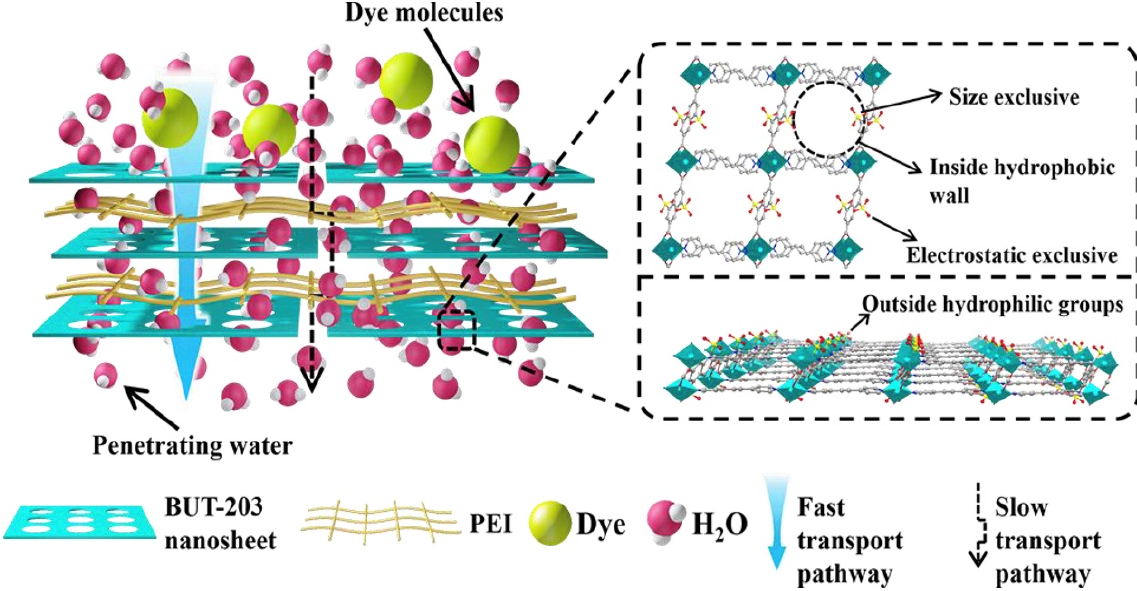
Figure 5. Proposed structure of modified membrane layers (MOF: BUT-23 nanosheet) [88] (Copyright 2020. Reproduced with permission from Elsevier.)